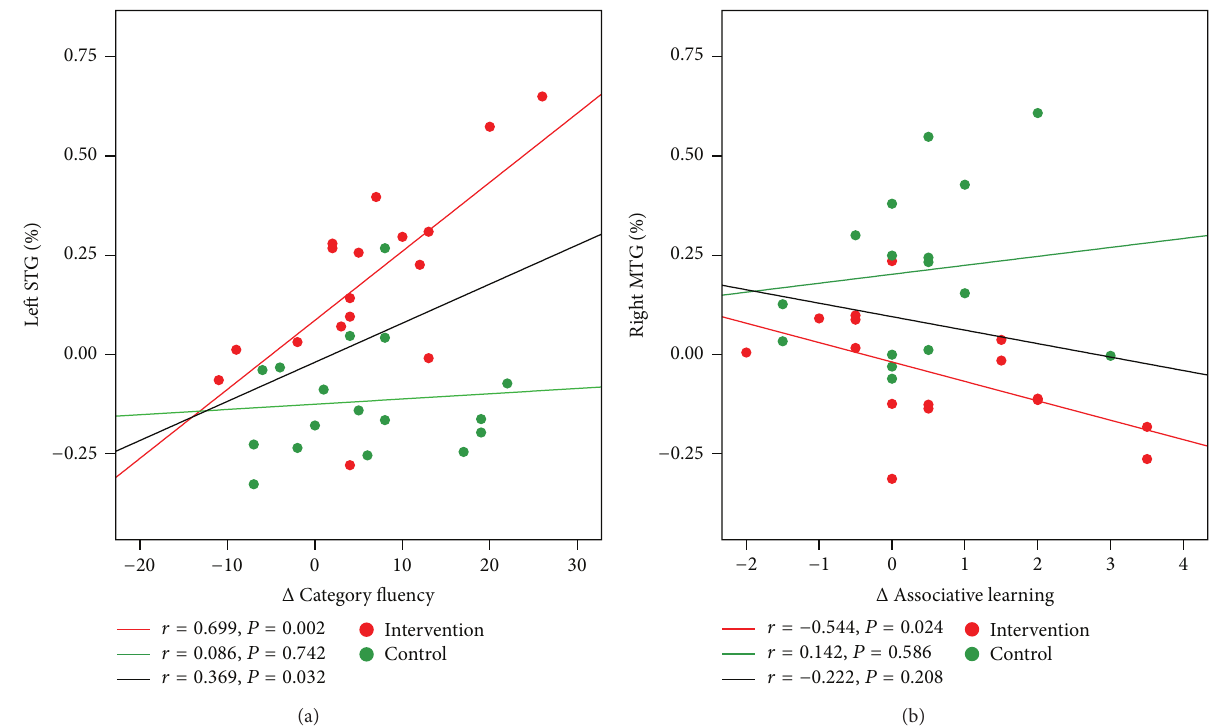
Figure4:Correlationsbetweentheintervention-relatedchangesinReHoofspontaneousbrainactivityandchangesincognitiveperformance for all participants. Data of the intervention group are colored in red and those of the controls are colored in green. The red fit line on each graph represents the relationship between theintervention-related changes in ReHo and cognitive performance in theintervention group, and the green fit line represents the relationship in the control group. The black fit line displays the relationship between the intervention-related changes in ReHo and cognitive performance for all participants from the two